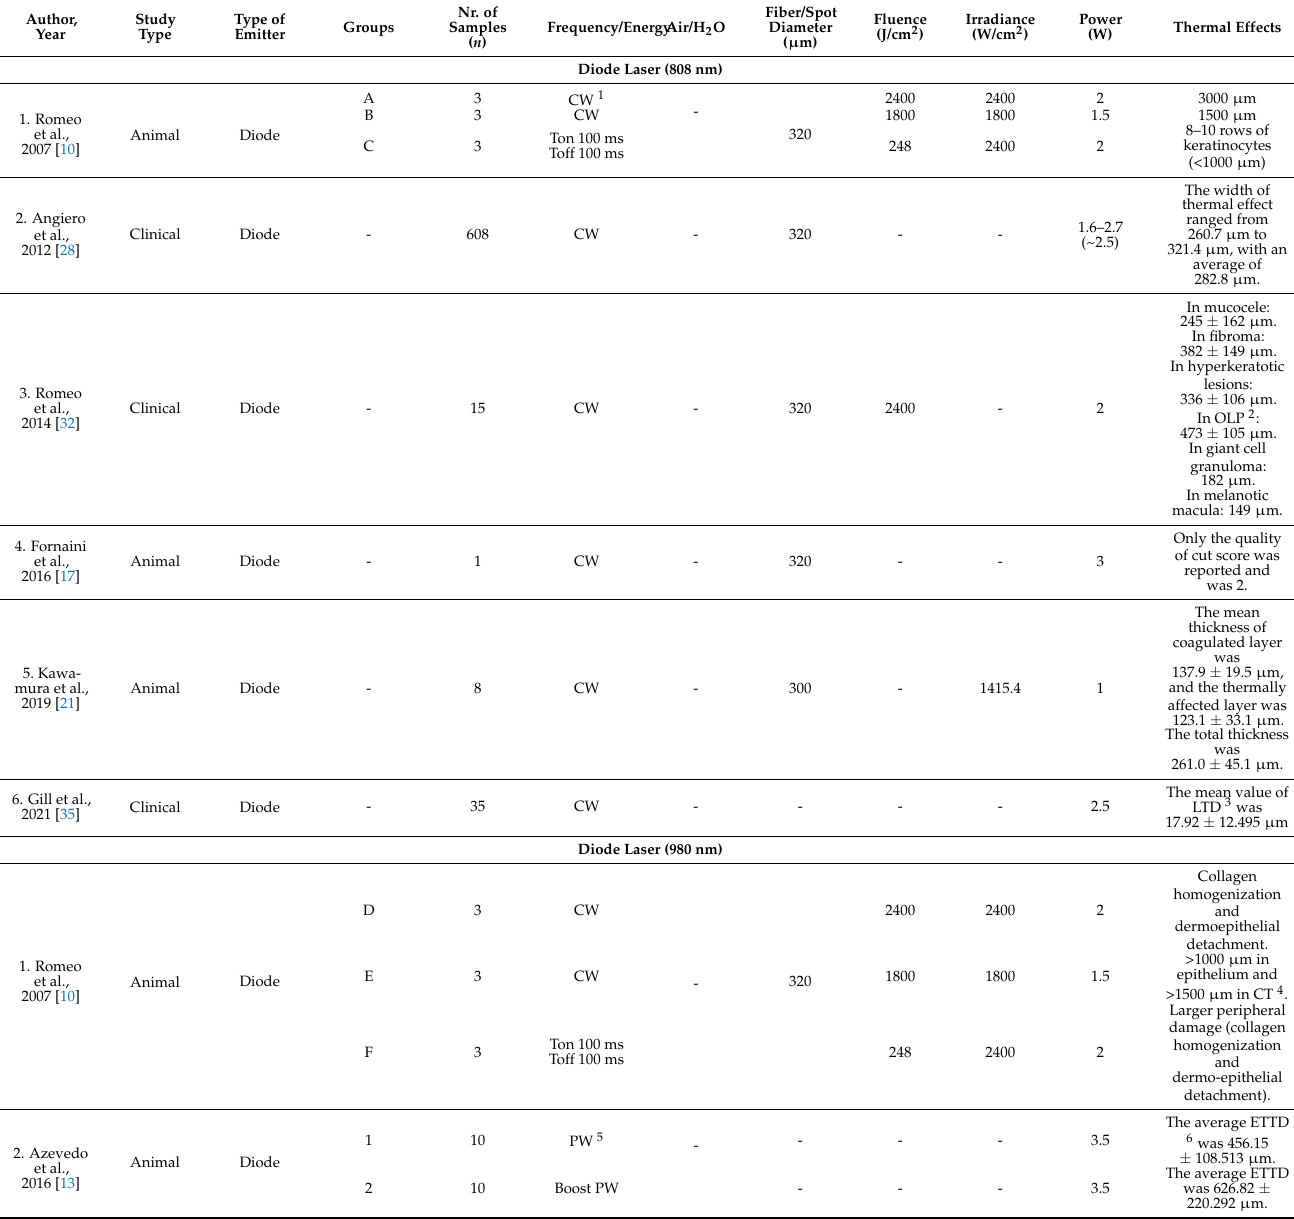
Table 4. Overview of laser parameters and the resulted thermal effects of the included studies.